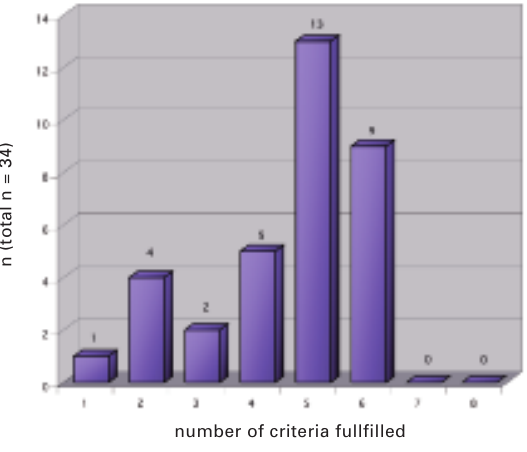
Number of fertile men who reach normal criteria (pH, volume, concentra- tion, total count, total motility, grade a motility, viability, Tygerberg’s criteria) (n = 34).